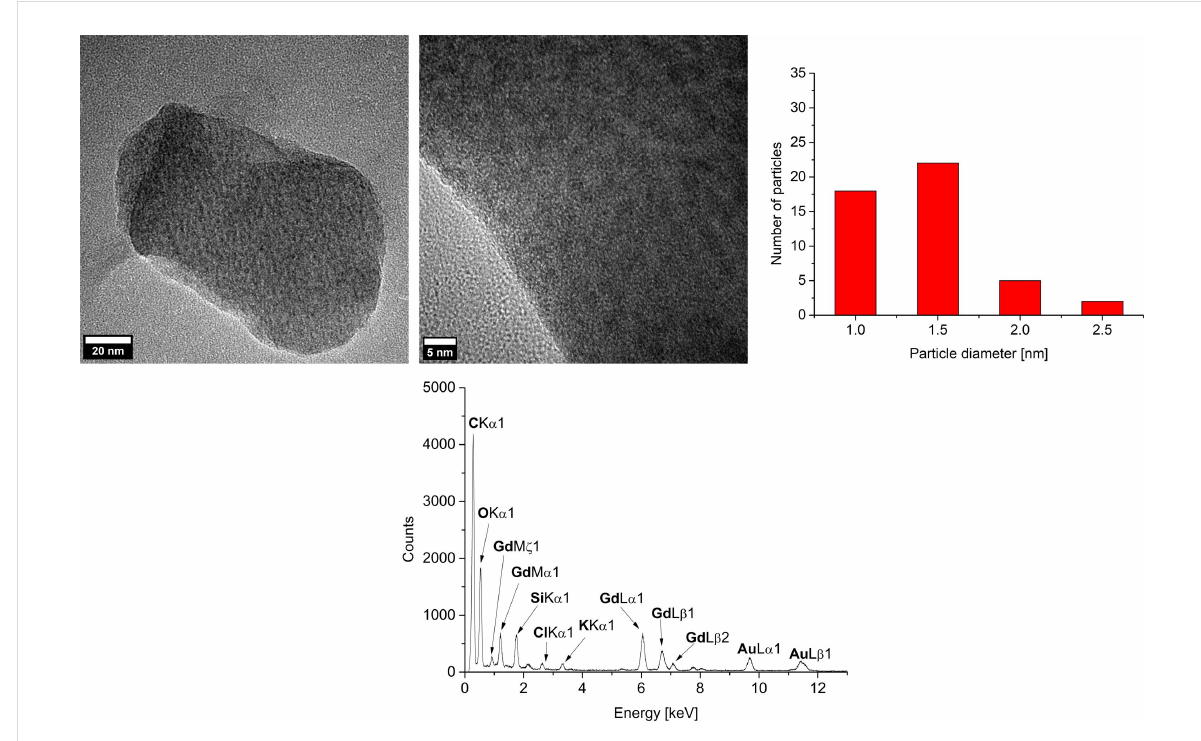
Figure 9: TEM images, particle-size histogram and EDX of 1.0 wt % Gd-NPs in PC from Gd(amd) 3 .